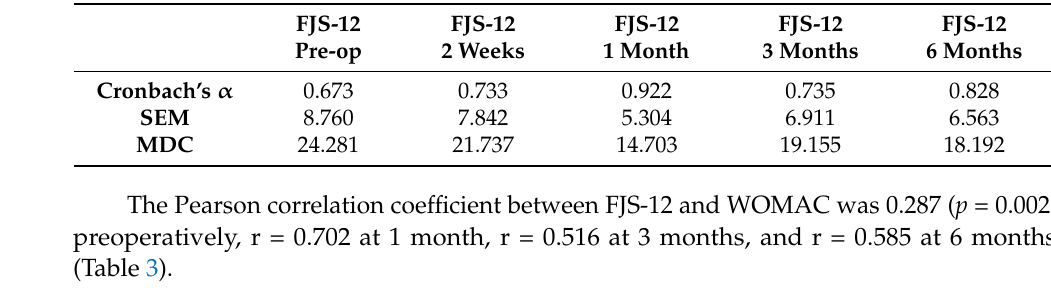
Table 3. Pearson correlation